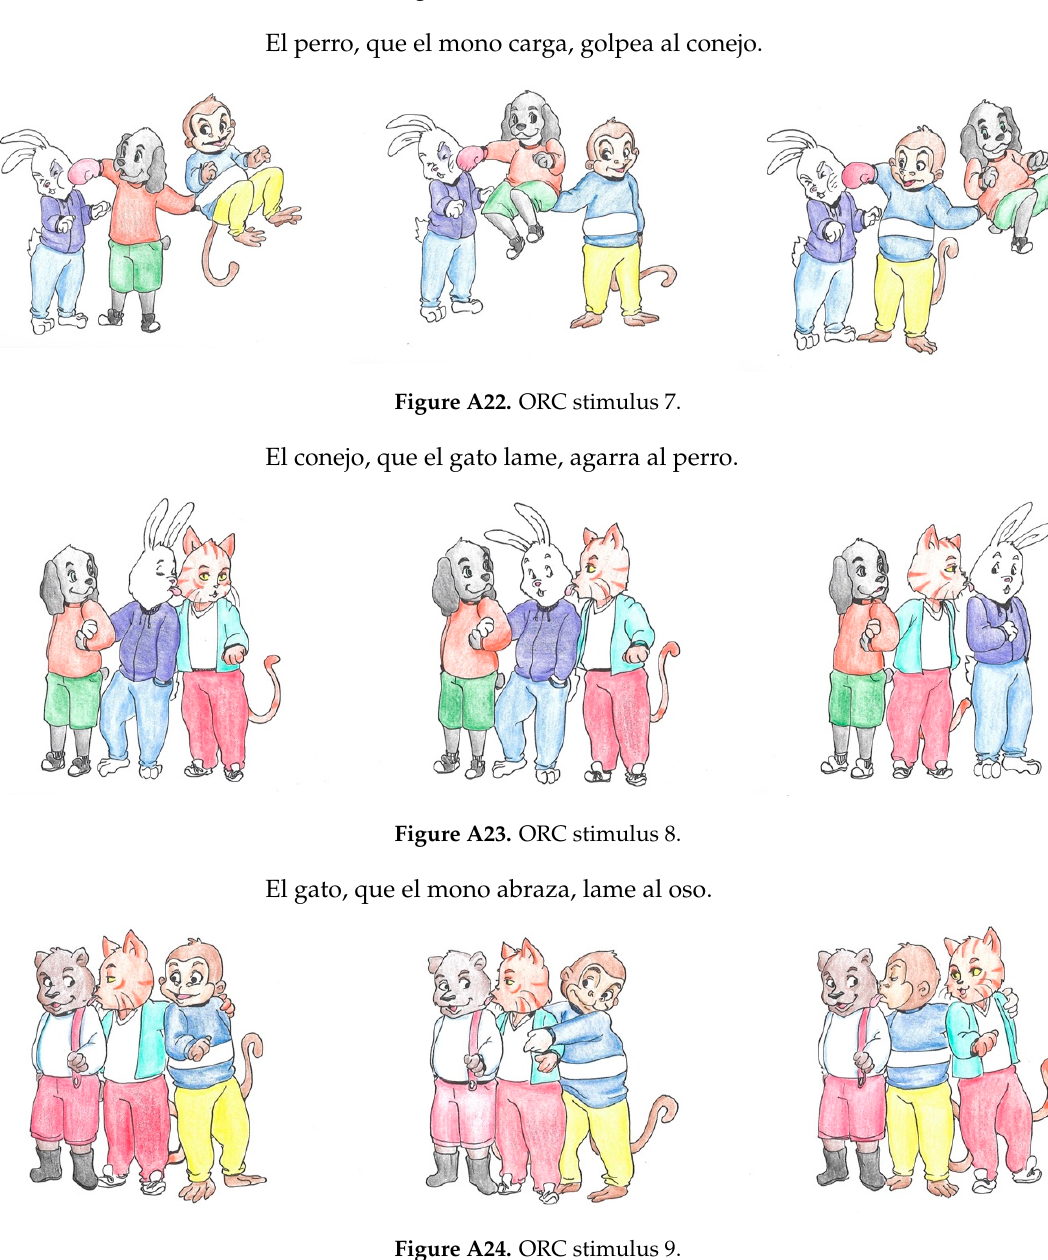
Figure A21. ORC stimulus 6.